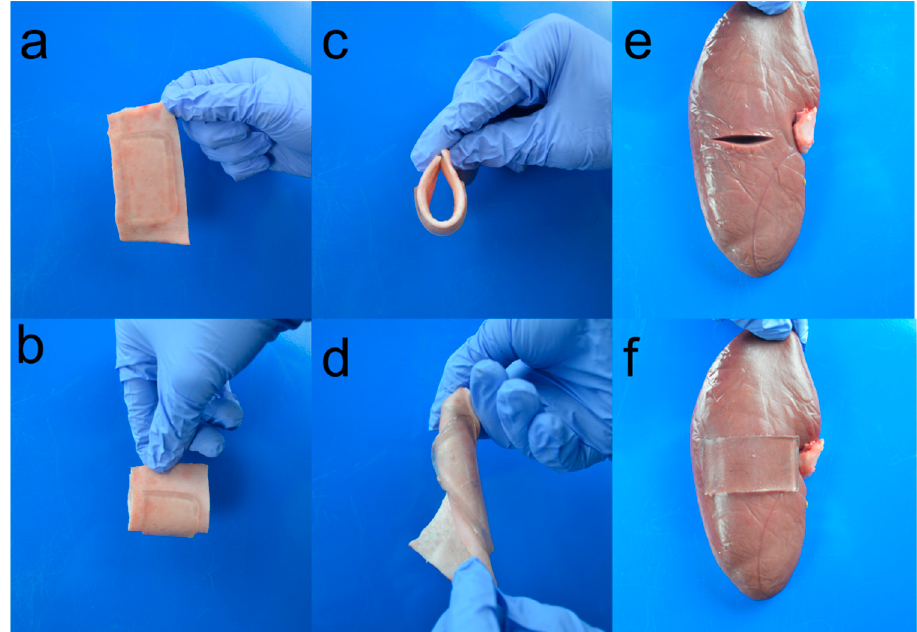
Figure 4. Photographs of the hydrogel bonded to pig skin ( a ) in the state of dangling, ( b,c ) being bent, and ( d ) twisted. Photographs of hydrogel adhesive adhered to pig kidney. ( e ) A notch was made in the pig kidney. ( f ) Hydrogel bonds to the pig kidney surface and connects the two sides.